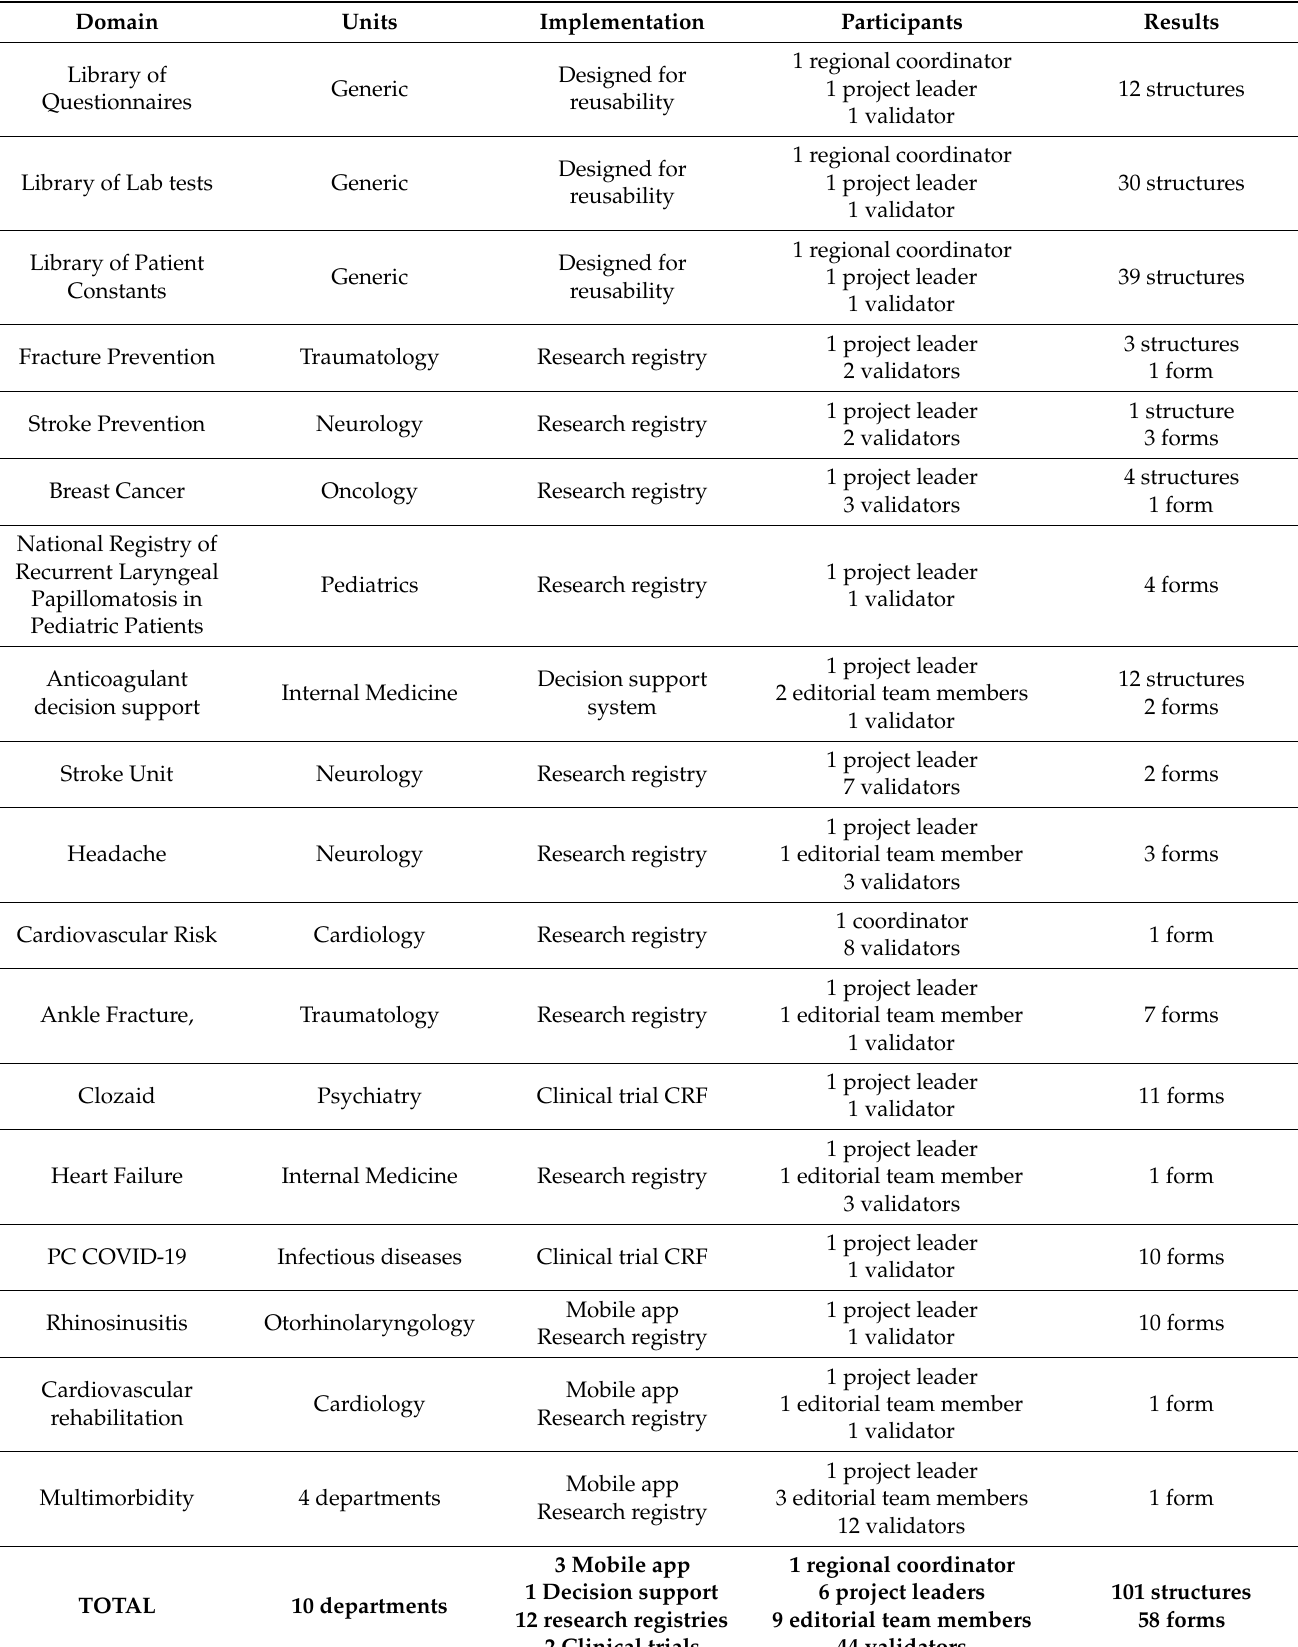
Table 3. Details of the projects where the MedicalForms system was